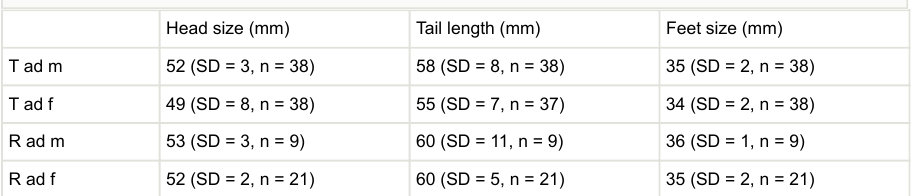
Mean values of the standard morphometric measurements of the adult ground squirrels captured in Momina tsarkva throughout the year (R) and of those translocated from Topolchane (T). n = sample size, SD = standard